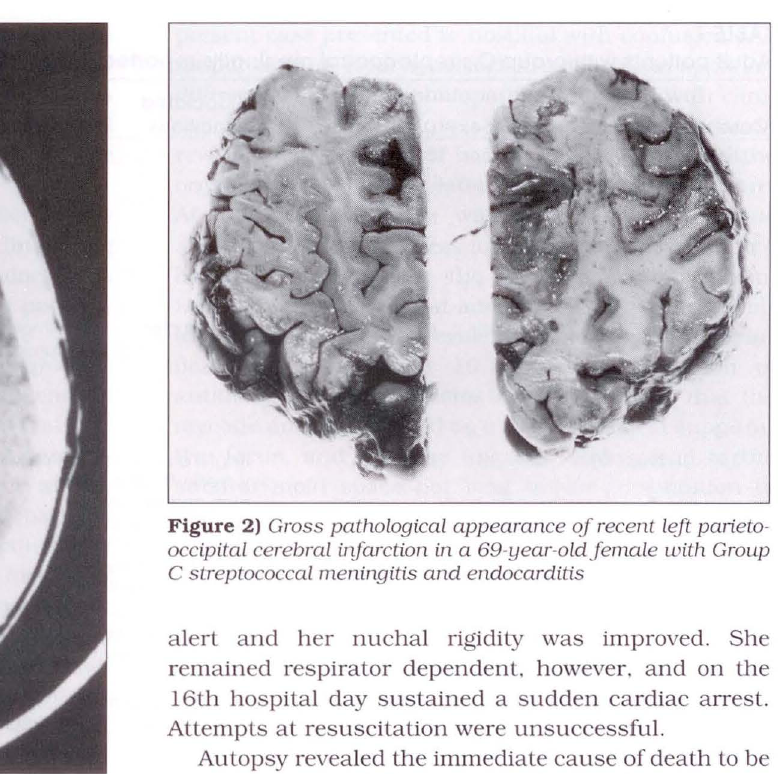
Figure 2) Gross pathological appearance of recent left parieto occipital cerebral infarction in a 69-year-oldfemale with Group C streptococcal meningitis and endocarditis alert and her nuchal rigidity was improved. She remained respirator dependent. however, and on the 16th hospital day sustained a sudden cardiac